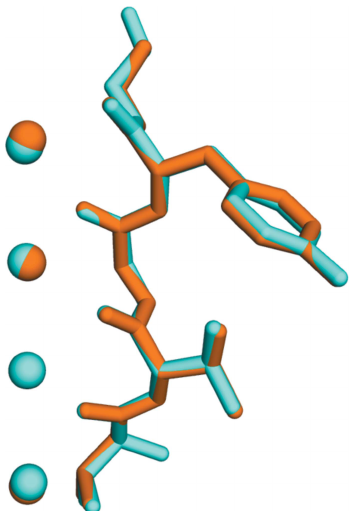
Figure 1 The KcsA amino acid residues that form the selectivity filter, Thr75 to Gly79, and four potassium ions are shown in cyan, while residues Thr63 to Gly67, which form the NaK2K selectivity filter, and four potassium ions are shown in orange. The main-chain RMSD for these residues is only 0.12 A˚ , indicating that the selectivity filters are